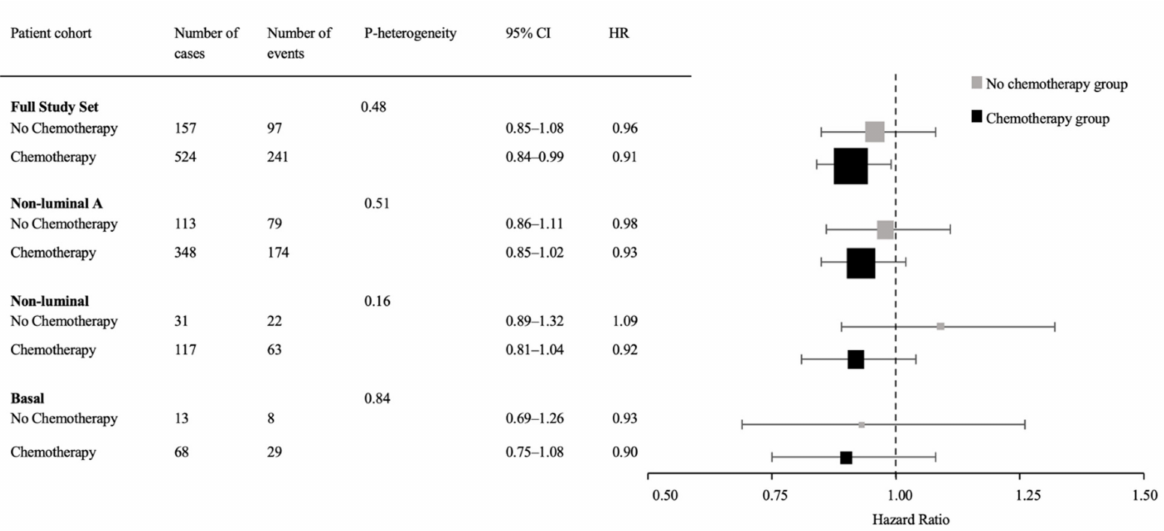
Figure 4. Forest plot showing adjusted hazard ratios and corresponding 95% confidence intervals for a 10-point difference in continuous H&E sTIL according to the treatment regimens. These analyses were performed for the full study set (primary objective), in the non-luminal A subset (secondary objective), and in the basal and non-luminal subsets (exploratory). Due to the limited number of the events, unadjusted estimates are presented for the basal subset. The box sizes represent the sample size (number of the cases in each subgroup analysis). CI: confidence interval, HR: hazard ratio, H&E: hematoxylin and eosin, sTIL: stromal tumor-infiltrating lymphocyte. Table 2. Adjusted hazard ratios (HR) and corresponding 95% confidence intervals (CIs) are shown for the chemotherapy versus no chemotherapy arms according to the biomarker status (low/negative and high/positive) in the full study set and in the non-luminal A subset. sTIL: stromal